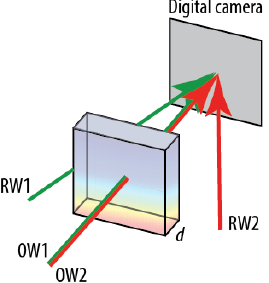
Fig. 3. Principle scheme of DWSCI. Objet waves (OW1, OW2) integrating the measured phase change imping perpendicularly on the CCD or CMOS while the reference waves for different wavelengths (RW1, RW2) imping tha sensor at different angles in order to generate different spatial carrier frequencies.